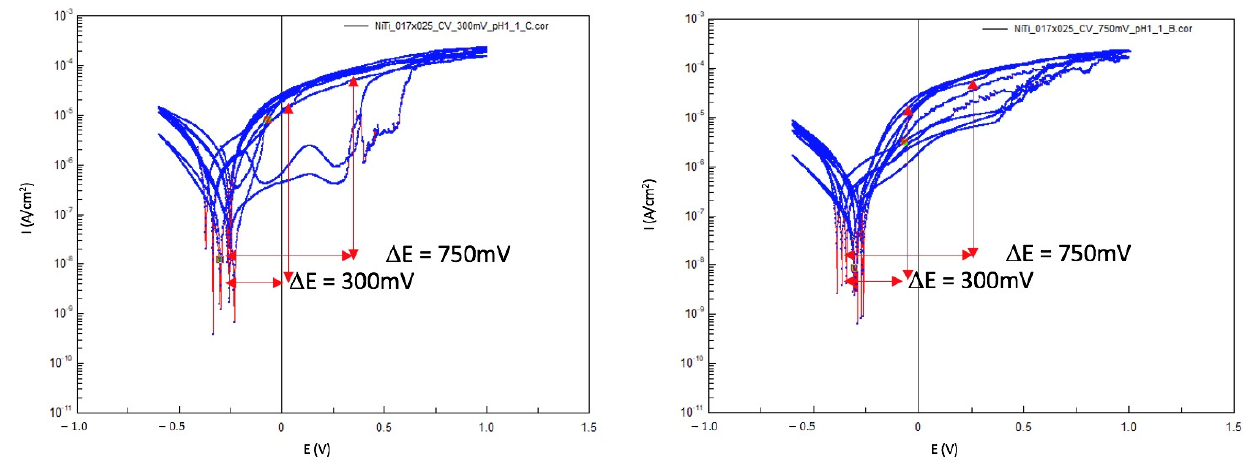
Figure 8. Two CV Log(i) versus E curves from two NiTi wires in Ringer’s solution pH = 1, RT; the positions for polarization are marked with red arrows.